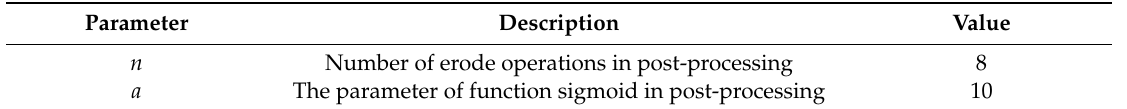
Table 7. Experiment parameters of saliency